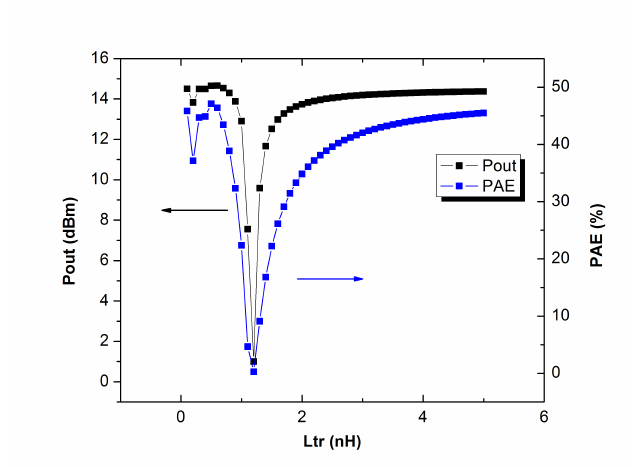
Figure 19. Overall performance versus L